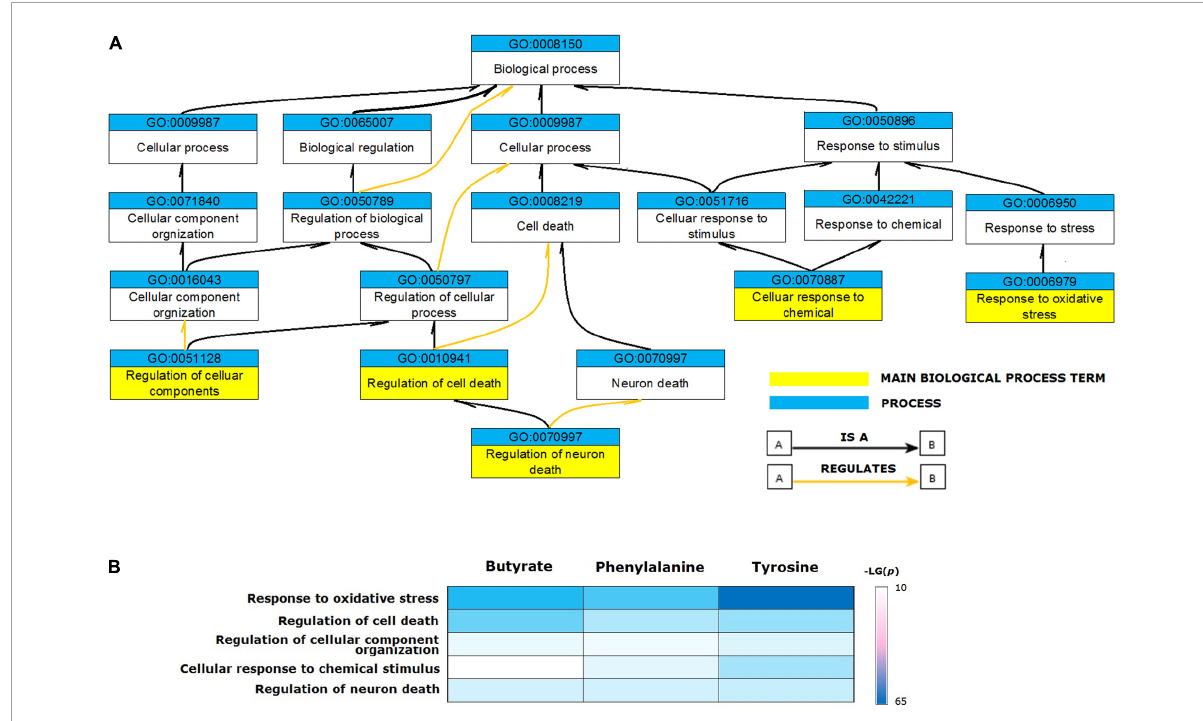
FIGURE3 Biological processes enriched for validated metabolite gene sets. (A) The ancestor chart for enriched GO terms represented by the 106 genes contained in the CTD term “Parkinson’s Disease”. (B) The validated metabolites influenced five main biological process GO terms associated with Parkinson’s